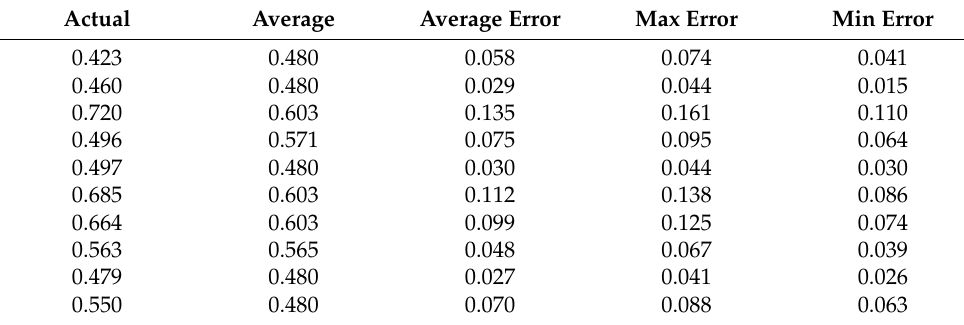
Table A217. Set 3, trials 41–50 data (single 0.5 PR value).